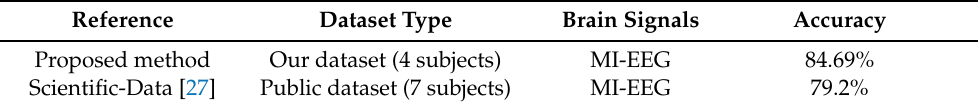
Table 7. Accuracies achieved with our and Scientific-Data